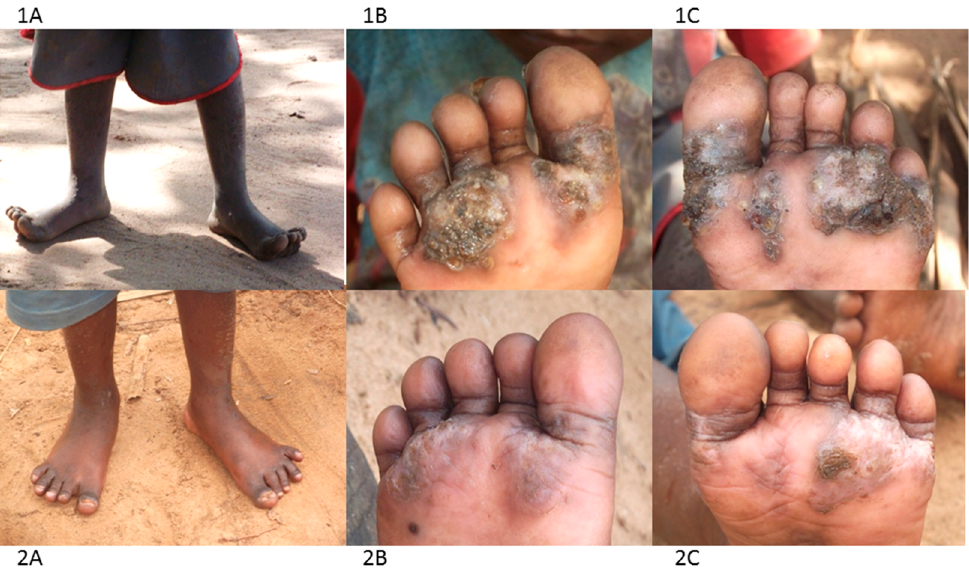
Figure 3. Photographs illustrating the impact of neem and coconut herbal medicine ontungiasis infection and pathology ( 1A – C before treatment; 2A – C after 5 applications).